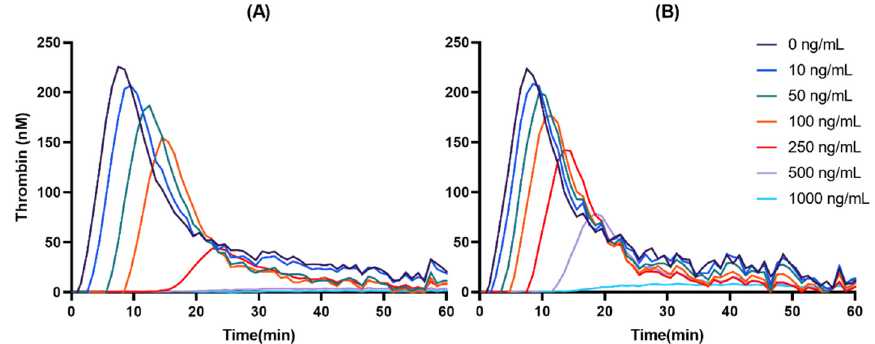
Figure 2. Representative thrombin-generation inhibition by DAB ( A ) and DABG ( B ). Comparing the inhibitory potency of DAB and DABG on thrombin generation, the calculated IC 50 values of DAB and DABG based on AUCs were 134.1 ng/mL and 281.9 ng/mL, respectively, suggesting that DAB showed 2.10-fold more potent inhibitory effect than DABG. The calculated IC 50 values of DAB and DABG for thrombin generation are shown in Table 2. Table 2. IC 50 values of dabigatran (DAB) and dabigatran acylglucuronide (DABG) on thrombin gen- eration assays ( n = 5).